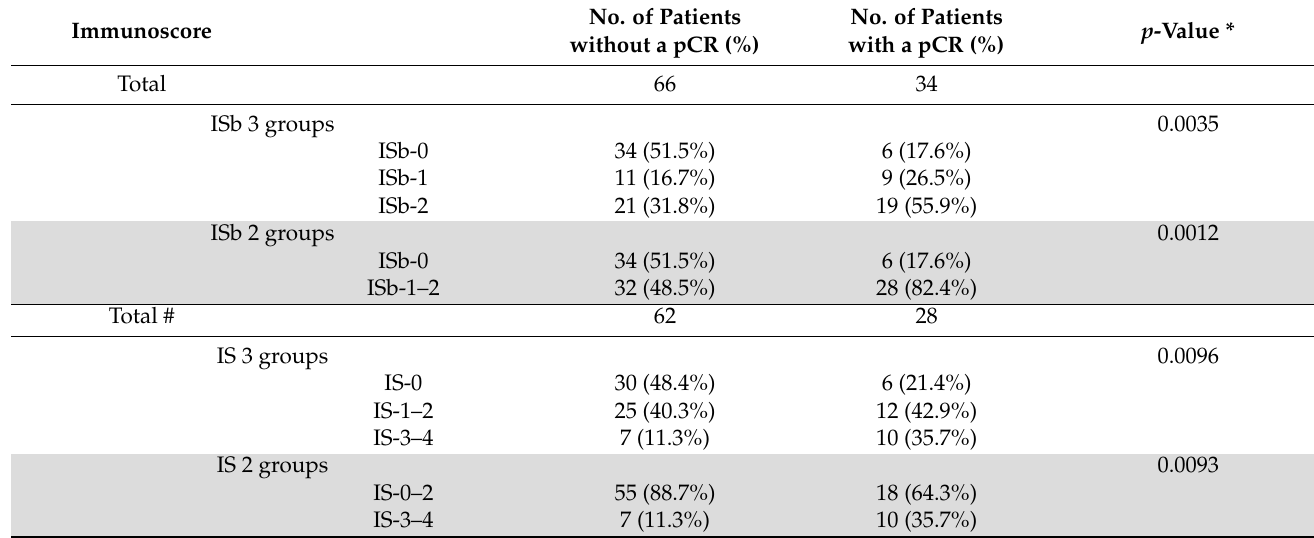
Table 2. Pathological complete response distribution according to the Immunoscore